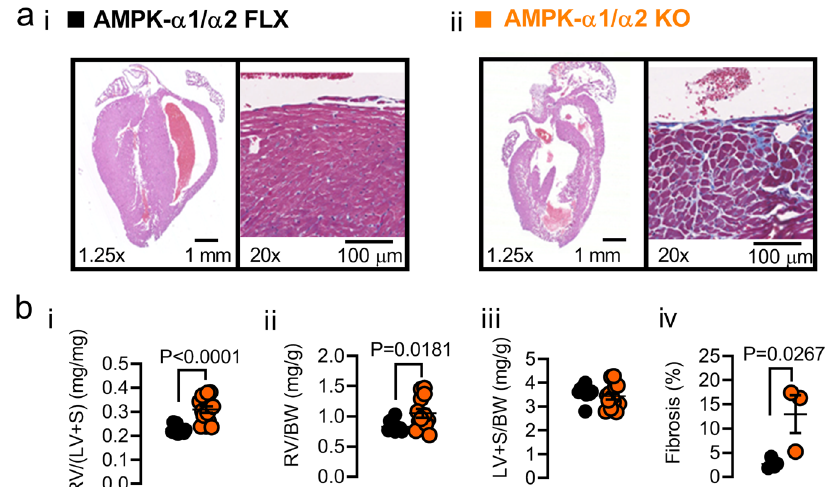
Fig. 2 | AMPK- α 1/ α 2 deletion precipitated remodeling of the heart. a Representative sub-gross images of heart slices from terminal samples stained with Hematoxylin – Eosin (left) and a higher magni fi cation image showing the right aspect of the septal myocardium including right ventricular endocardium stained with Masson ’ s trichrome (right) for (i) AMPK- α 1/ α 2 fl oxed (AMPK- α 1/ α 2 FLX) and (ii) AMPK- α 1/ α 2 knockouts (AMPK- α 1/ α 2 KO). b Scatter plots show the (i) Fulton